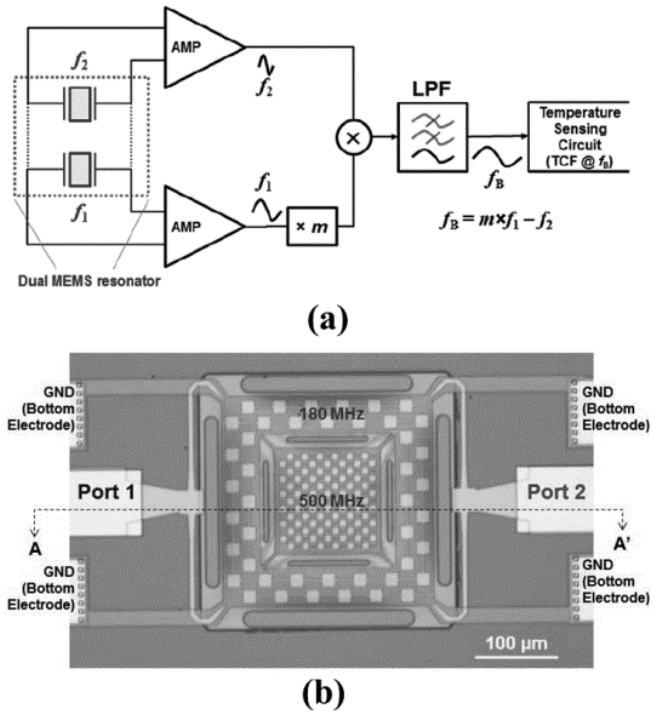
Figure 18. ( a ) schematic of beat frequency-based sensor system; ( b ) Optical picture of the concentric dual AlN MEMS Resonators. Reproduced with permission from [113]. Copyright © 2017, IEEE. Generally, DC-UCRB sensors are promising in designing high-sensitivity sensors.